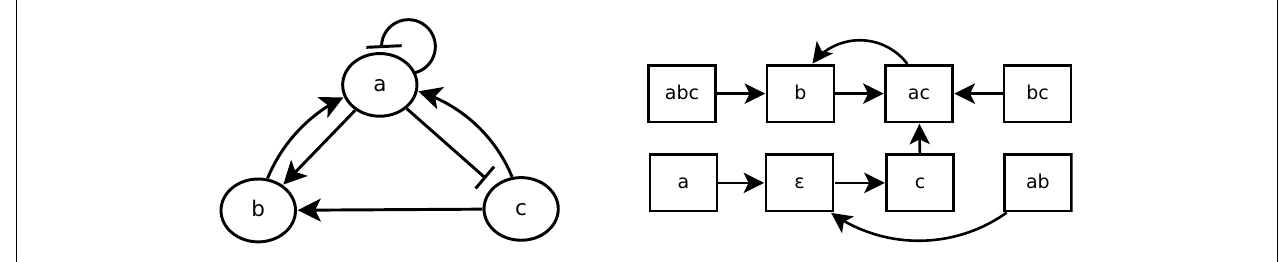
FIGURE 2 |A Boolean network B 1 (left) and its state transition diagram (right)